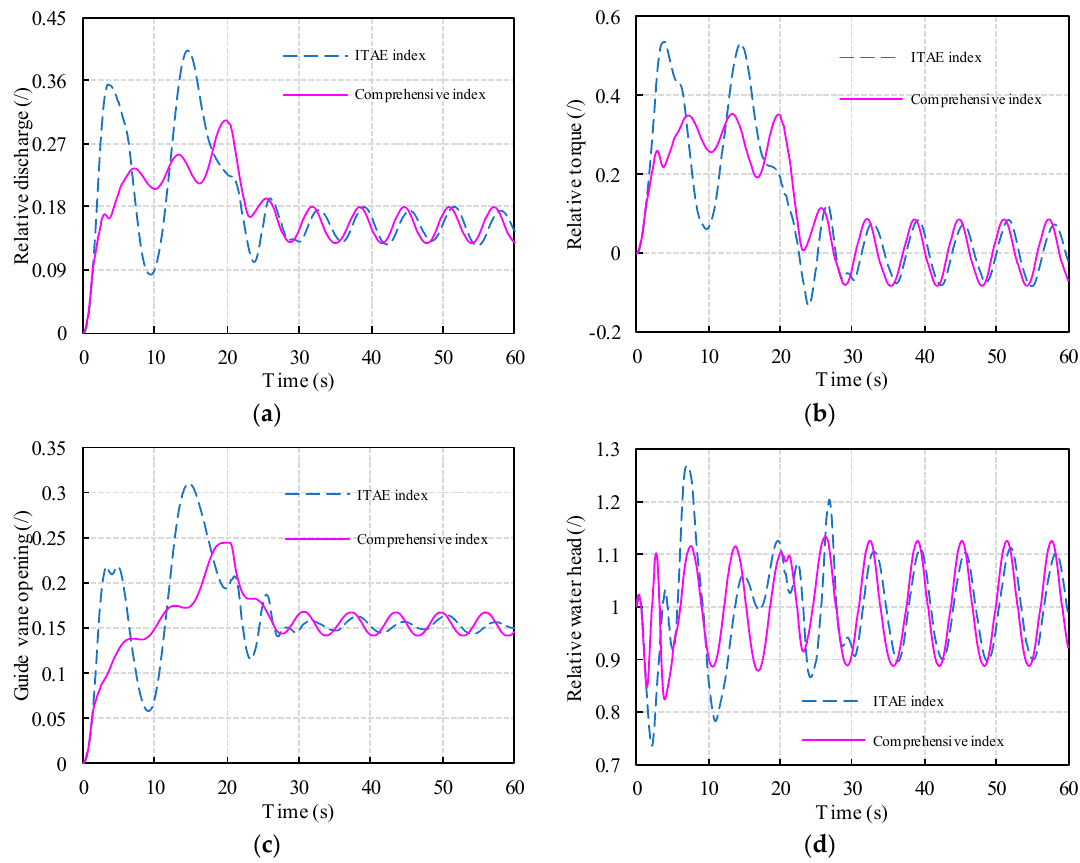
Figure 12. Optimization contrast curve of start-up characteristics: ( a ) Time history of discharge; ( b ) time history of torque; ( c ) time history of guide vane opening; and ( d ) time history of water head.